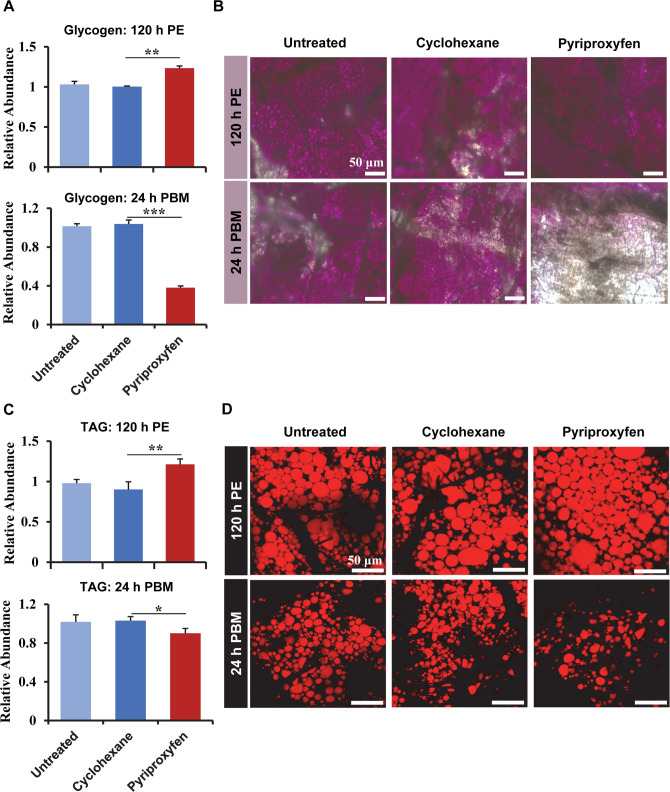
PPF exposure affected the levels of Glycogen and TAG.Female mosquitoes were treated with PPF (70 μg/cm2) at 72 h PE. (A) Quantitative measurement of glycogen in the whole-body mosquitoes at 120 h PE and 24 h PBM. The levels of glycogen were normalized to the protein contents of the samples. The relative abundance of the untreated control is set at 1. Error bars represent the standard deviation (SD) of three biological replicates. The differences between the PPF-treated and cyclohexane-treated mosquitoes were analyzed using paired t-test (*, p < 0.05; **, p < 0.01; ***, p < 0.001). (B) Glycogen in the fat body was visualized after PAS staining. The intensity of the pink/ purple color reflects the levels of glycogen. (C) Quantitative measurement of TAG in the whole-body mosquitoes. The levels of TAG were normalized to the protein contents of the samples. (D) Nile red lipid staining of lipid droplets in the fat body. Scale bar, 50 μm. PE, Post eclosion; PBM, Post blood-meal.